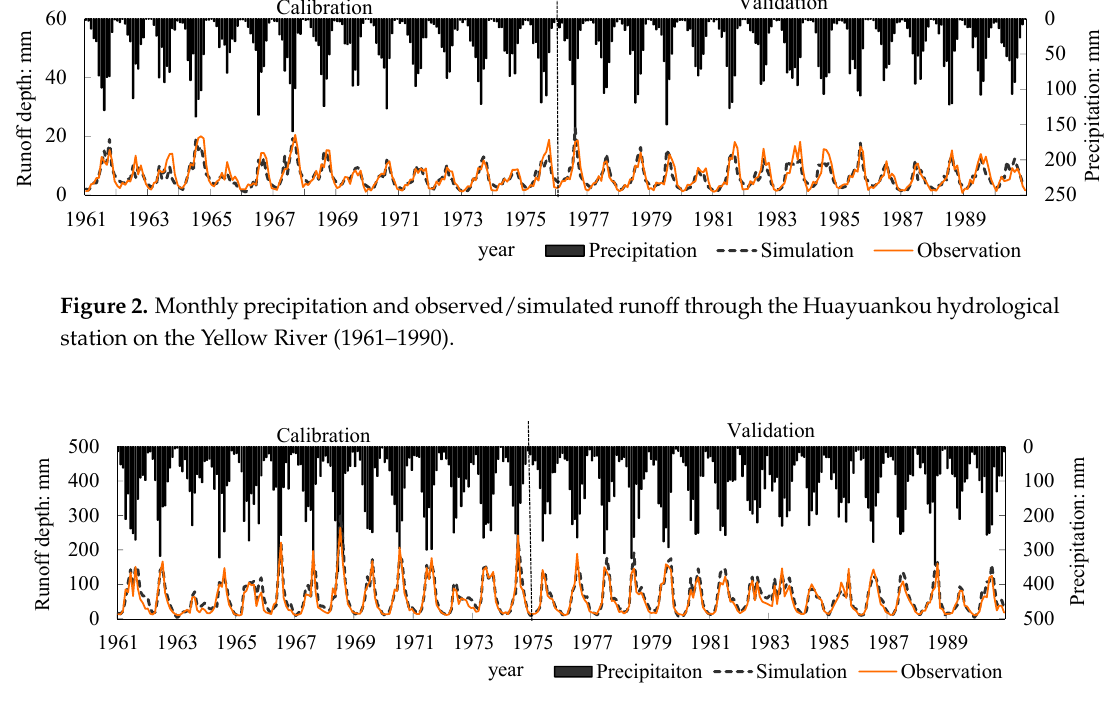
Figure 2. Monthly precipitation and observed/simulated runoff through the Huayuankou hydrological station on the Yellow River (1961–1990).